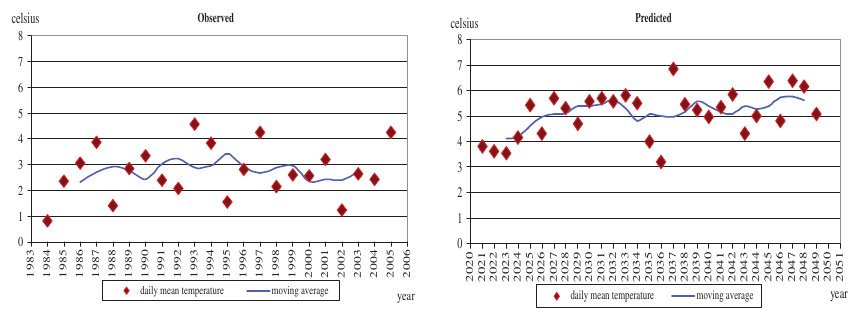
Figure 1. The average of the daily mean temperatures of the rest period of sour cherry (October-March) at Újfehértó, observed and calculated according to RegCM3.1